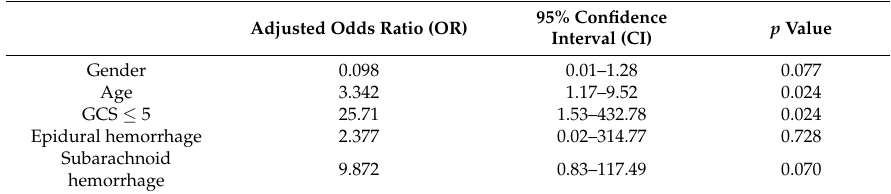
Table 3. Multivariate analysis examining the predictor of poor outcome after discharge of children with abusive head